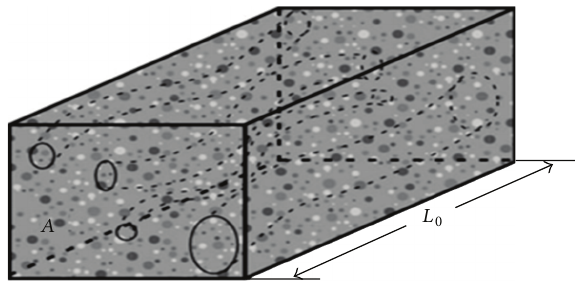
Figure 1: The model